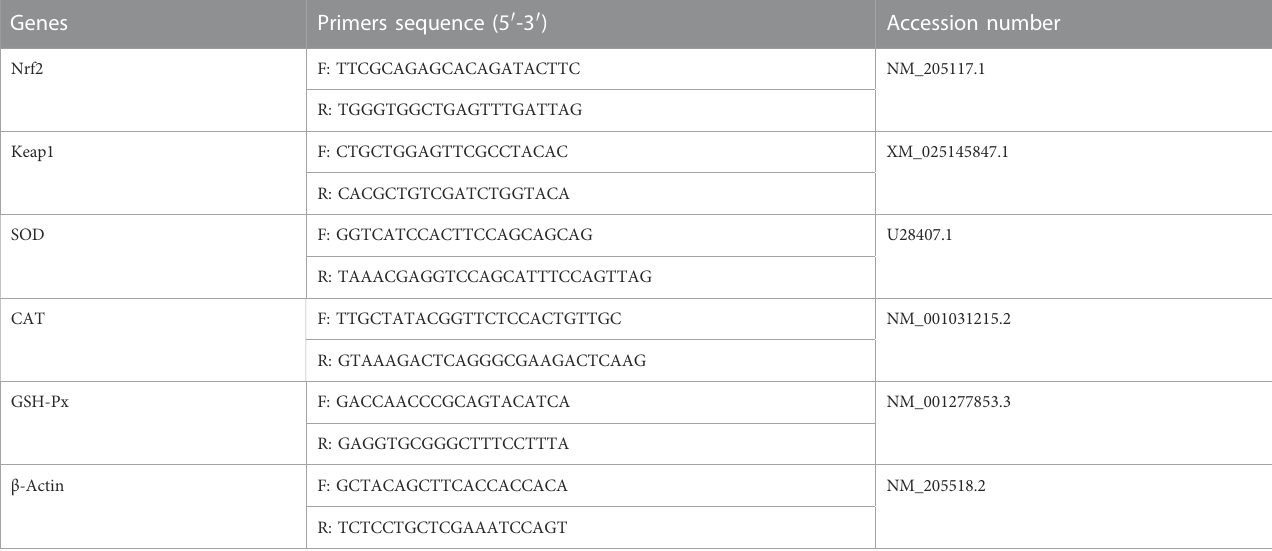
TABLE 2 Primer sequences used for quantitative real-time PCR. Genes Primers sequence (5 ′ -3 ′